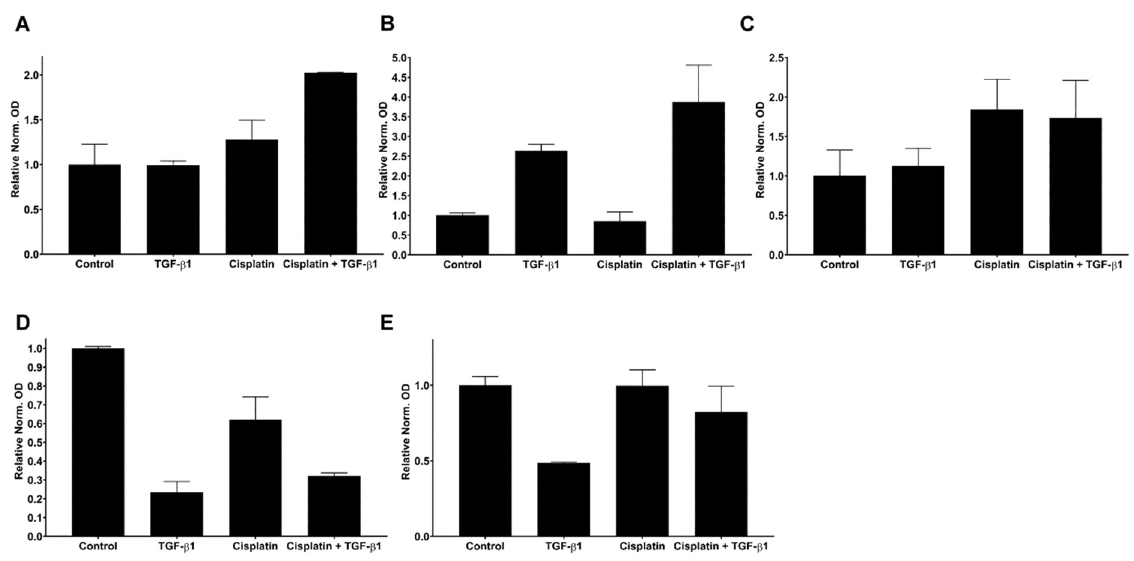
Figure 4. Quantification of the protein levels of Slug ( A ), Vimentin ( B ), p-p38 (MAPK) ( C ), KLF4 ( D ) and E-cadherin ( E ) from western blots presented in Supplementary Figure S2. GAPDH was used as loading control. All experiments were repeated as complete three biological repeats. Optical densities (ODs) of the bands of proteins of interest were normalized with the optical densities of GAPDH. The mean of the normalized ODs of control samples (only serum-free culture condition) were set to “1”.